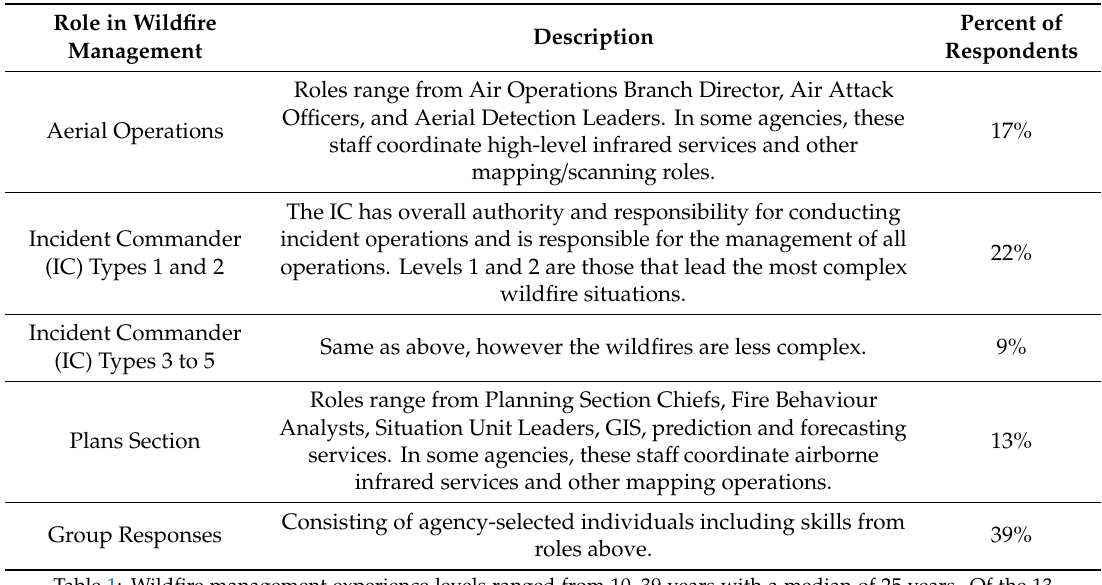
Table 1: Wildfire management experience levels ranged from 10–39 years with a median of 25 years. Of the 13 Canadian fire management agencies, 7 agencies responded to the survey (specifically: Agencies from Northwest Territories, British Columbia, Alberta, Saskatchewan, Ontario, Qu é bec, and Parks